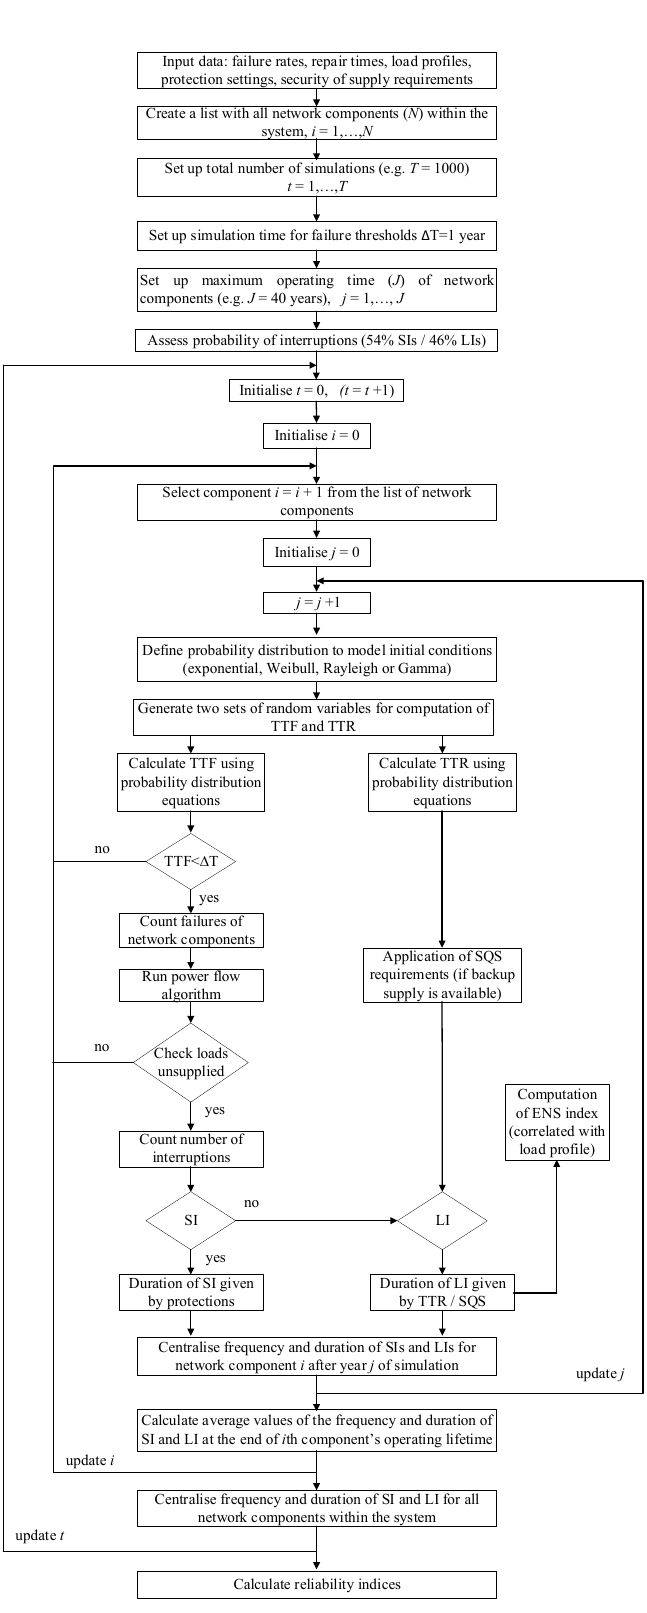
Figure 5. A general algorithm for the MCS-based reliability assessment procedure.